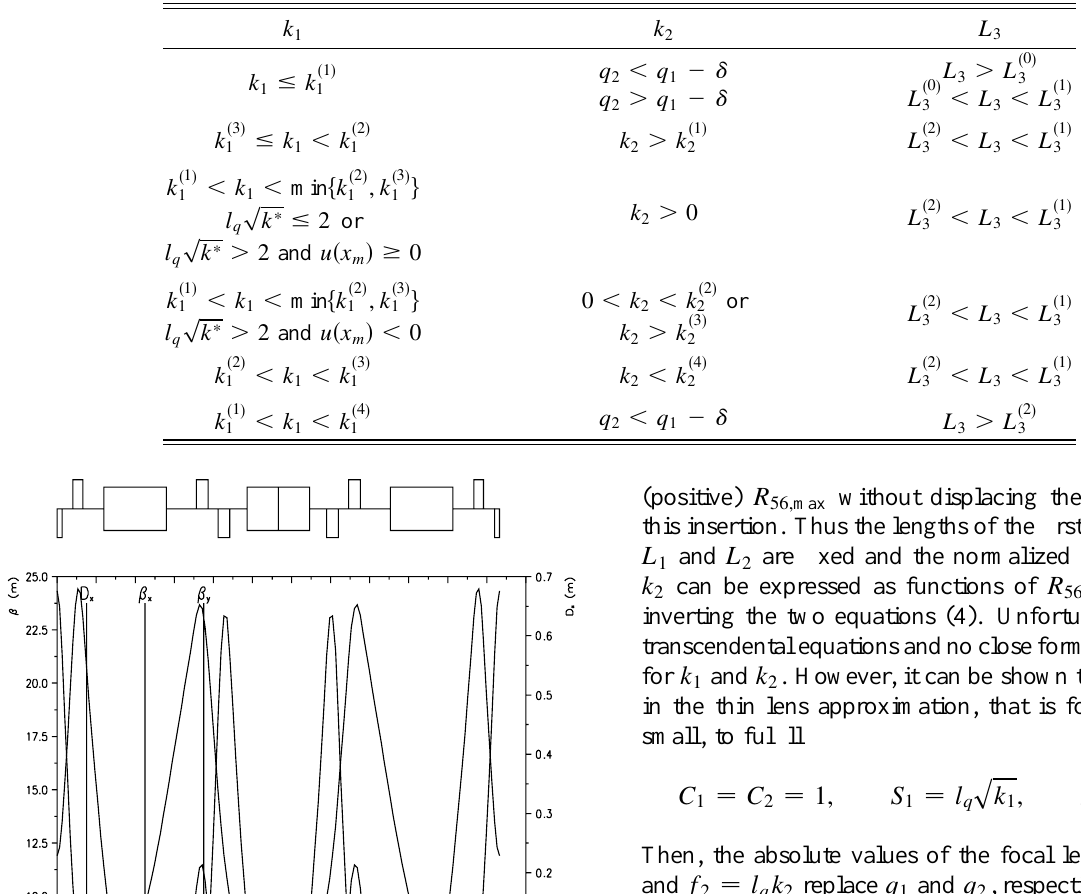
TABLE I. Valid ranges of k 1 , k 2 , and L 3 .